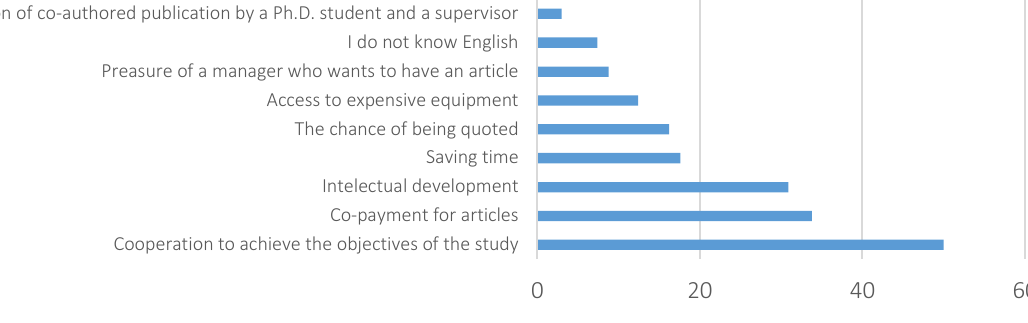
Figure 6. Motives and stimulus for publishing co-authored